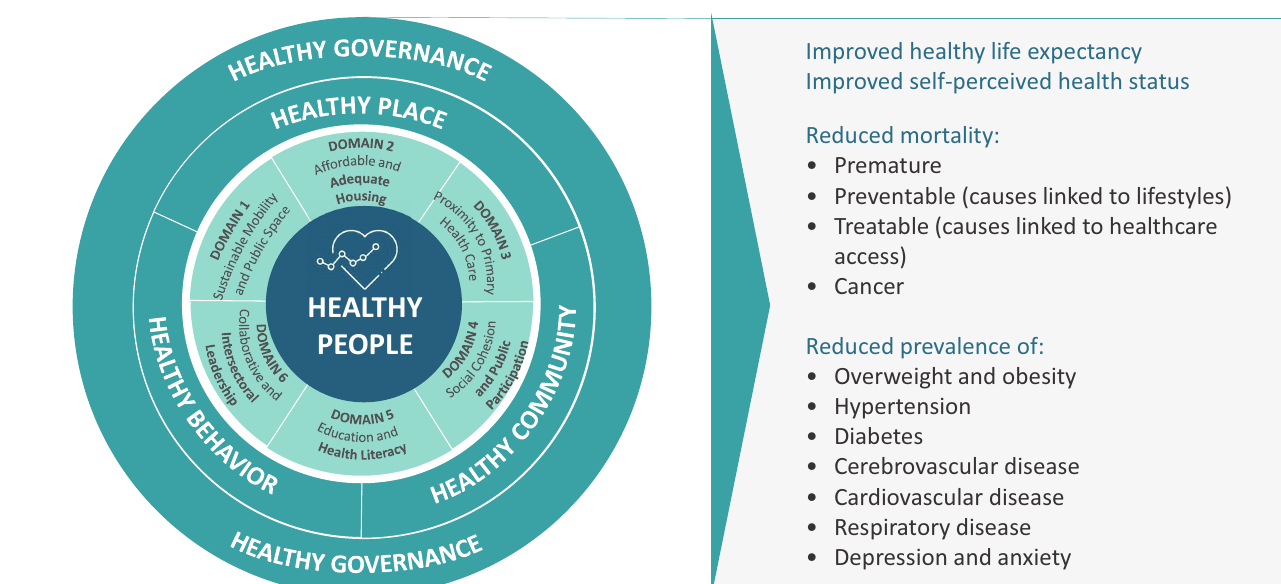
Figure 9. Strategic policy framework of the Coimbra Municipal Health Strategy. Source: Source: Câmara Municipal de Coimbra and University of Coimbra (2021).